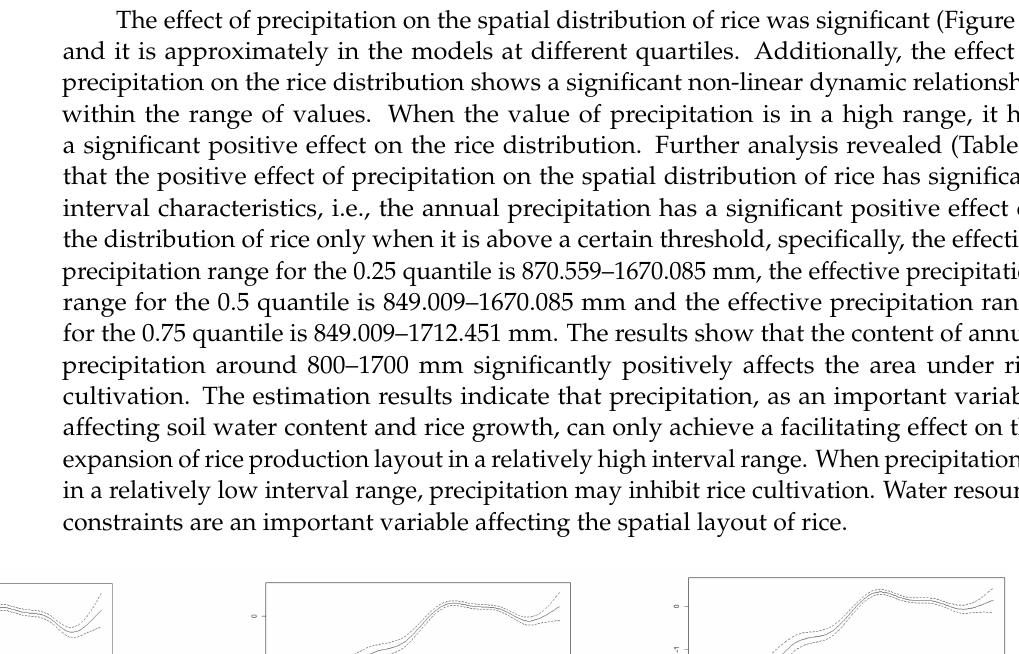
Figure 4. Results of non-linear quantile estimates of temperature on the rice patch area in ( a ) 0.25, ( b ) 0.5 and ( c ) 0.75 quantile.